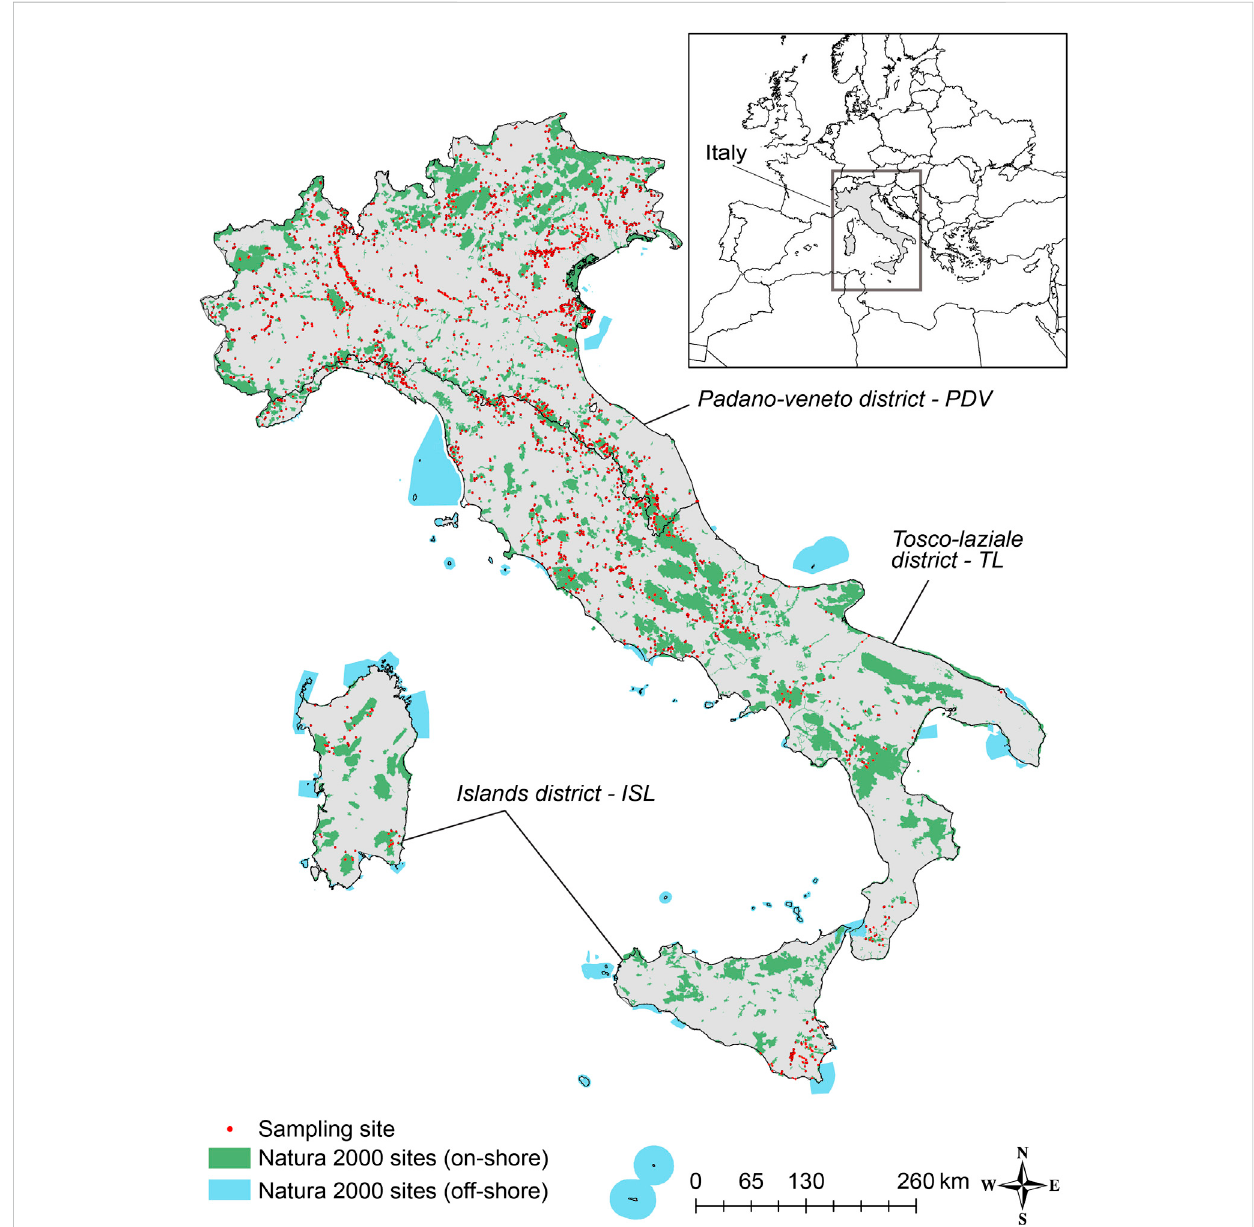
Mapshowingon-shore(green)andoff-shore(cyan)protectedareasofNatura2000network and3,777samplingsites(reddots).Thesolidblackline shows the border of the Padano-Veneto (PDV), Tosco-Laziale (TL), and Islands (ISL)